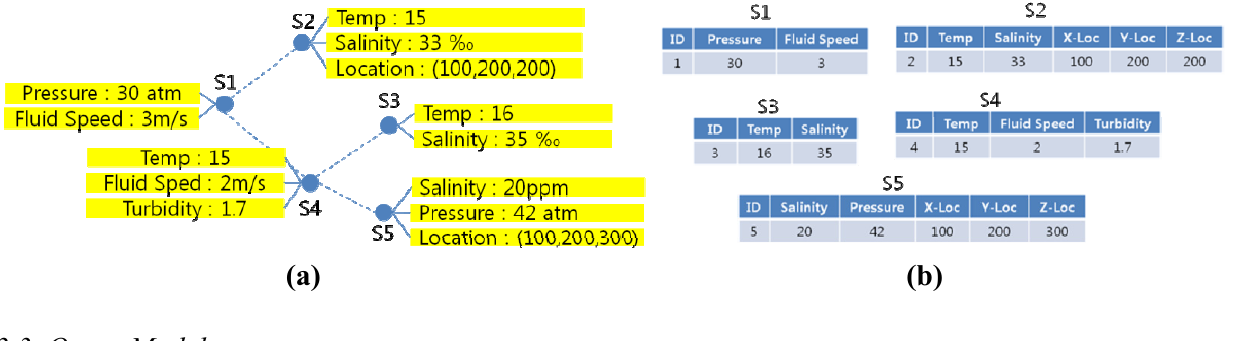
Figure 2. Example of a relational underwater sensor network database model. The sensor network in (a) can be mapped to a relational database model in (b) where each of the sensors is mapped to one of the current